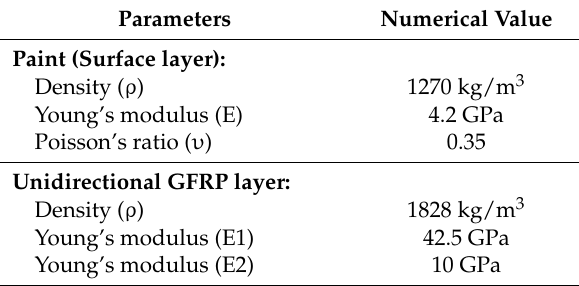
Table 2. GFRP material